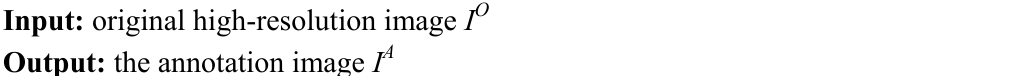
Algorithm 1. Algorithm of M 3 DA-RF Based Tile-level